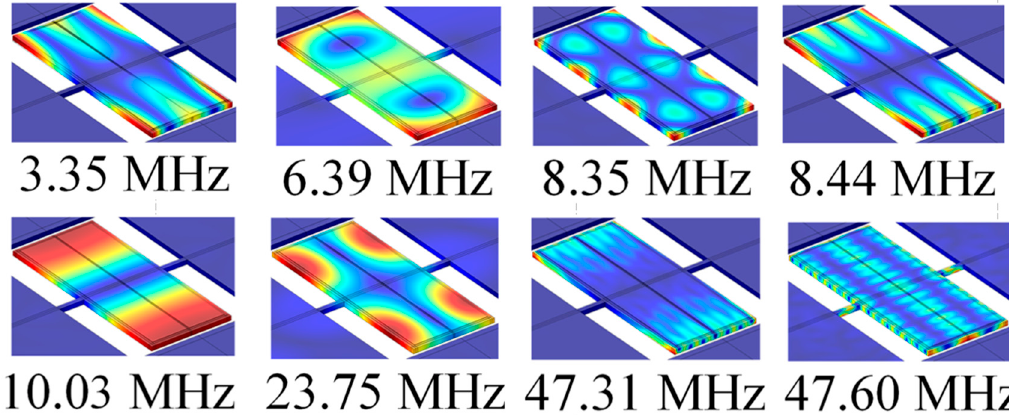
Figure 10. The mode corresponding to each resonance peak in the broadband S21 curve.